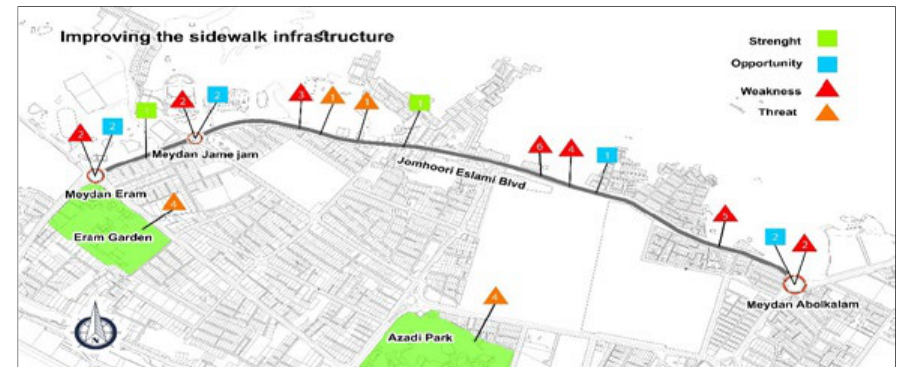
Fig. 3. Improving the sidewalk